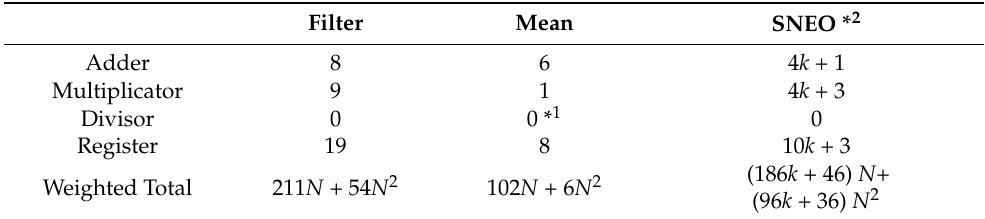
Table 4. Resources required by the hardware implementation of common blocks. The division by 7 in the mean block is implemented by a multiplication for the inverse of 7.